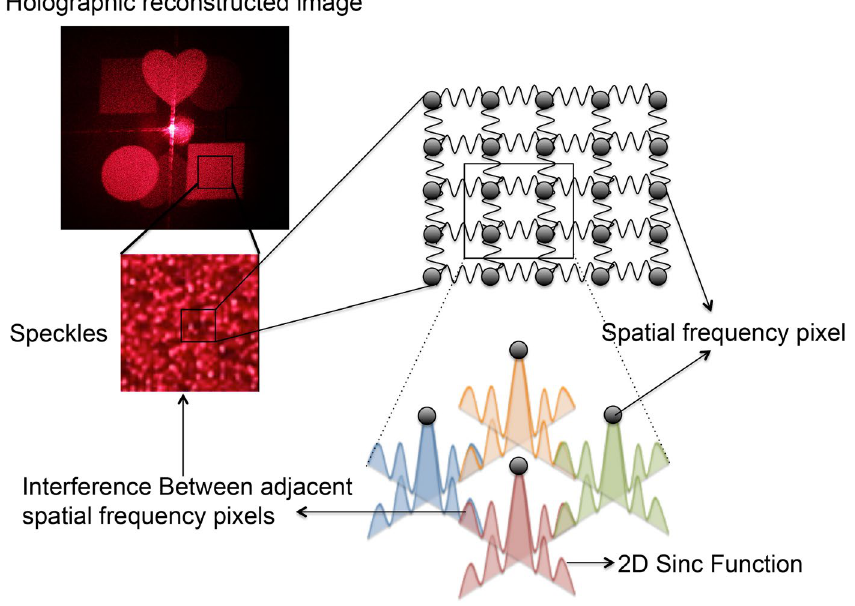
Figure 4. The formation of speckle from interference of high oscillation orders of adjacent spatial frequency pixels. The holographic reconstructed image is taken from the experiment result using DPSS laser shown in next section.